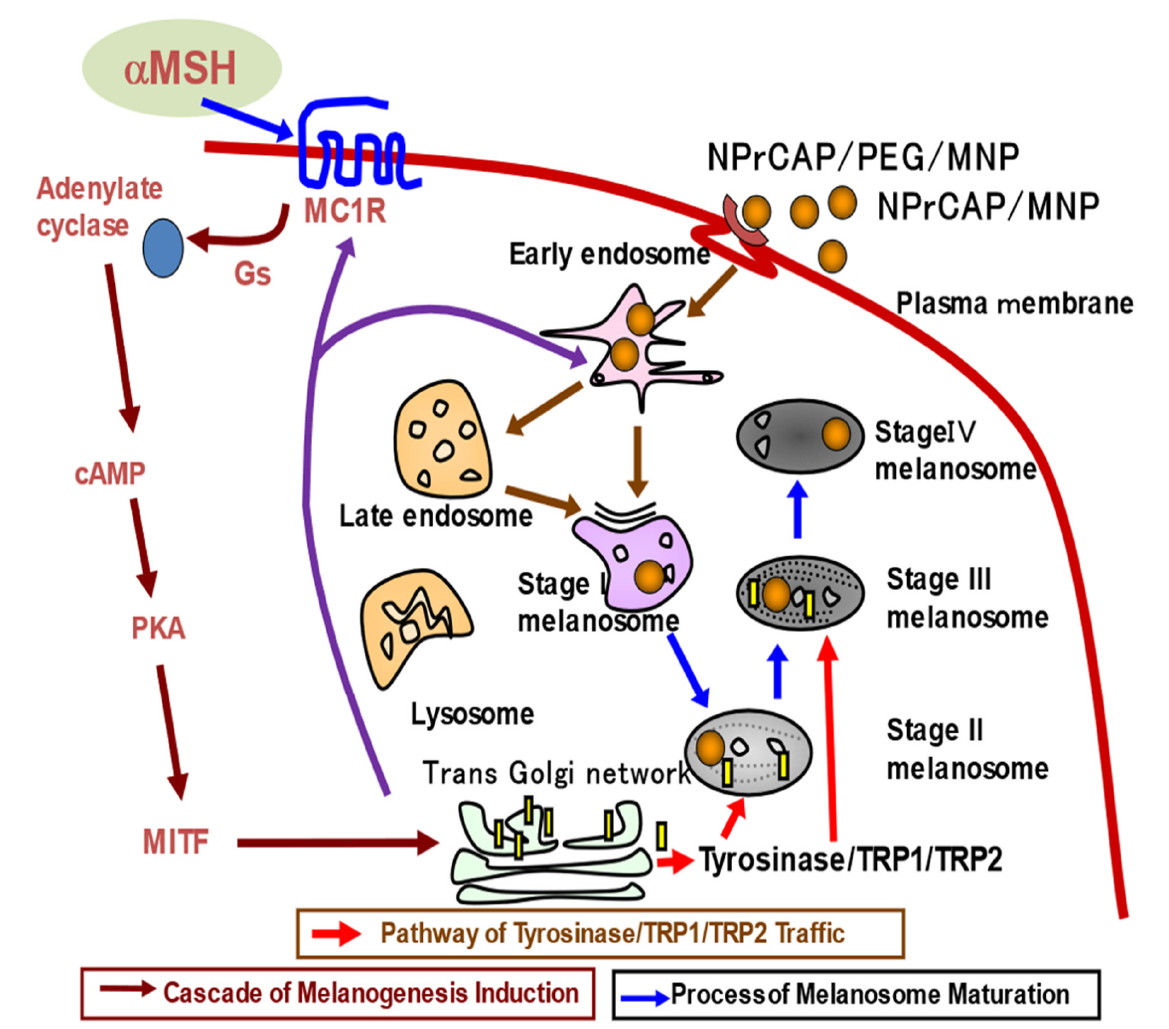
Figure 9. Selective accumulation of NPrCAP/MNP and NPrCAP/PEG/MNP.